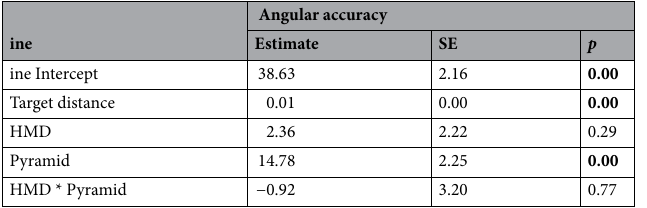
Table 2. Multiple linear regression model for Angular Accuracy of the Direction Estimation Task. Each dependent measure is modelled as a function of the predictors: Target Distance, Learning Condition (with DT as reference category), the model type (with Liver as the reference category) and their interaction. For each fixed effects and interaction, we report the coefficient and its standard error, along with the associated p -value. Statistically significant predictors (at the α = .05 level) are in